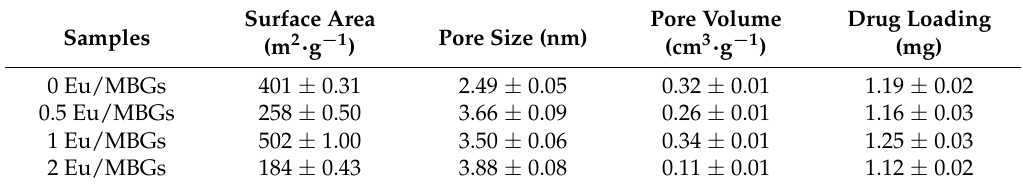
Figure 3. Nitrogen adsorption-desorption isotherm ( a ) and mesopore pore size distribution ( b ) of Eu/MBGs. Table 2. Textural parameters of the